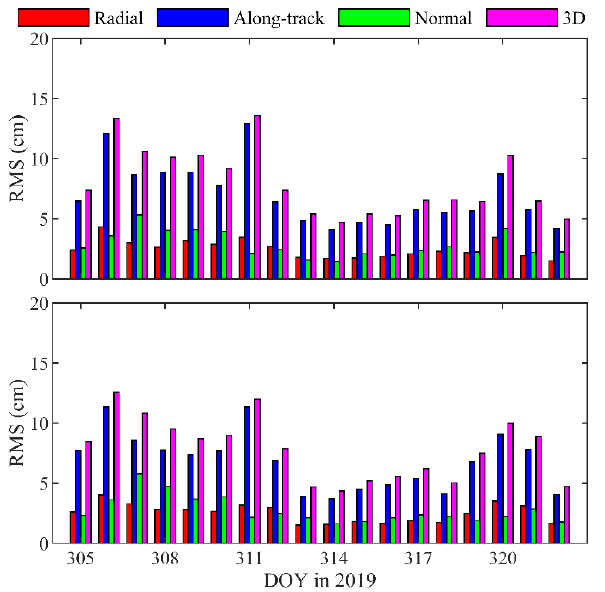
Figure 12. Orbit differences between BDS2 ‐ and GPS ‐ based POD in radial, along ‐ track, normal, and 3D directions for TH ‐ 2A ( top panel ) and TH ‐ 2B ( bottom panel